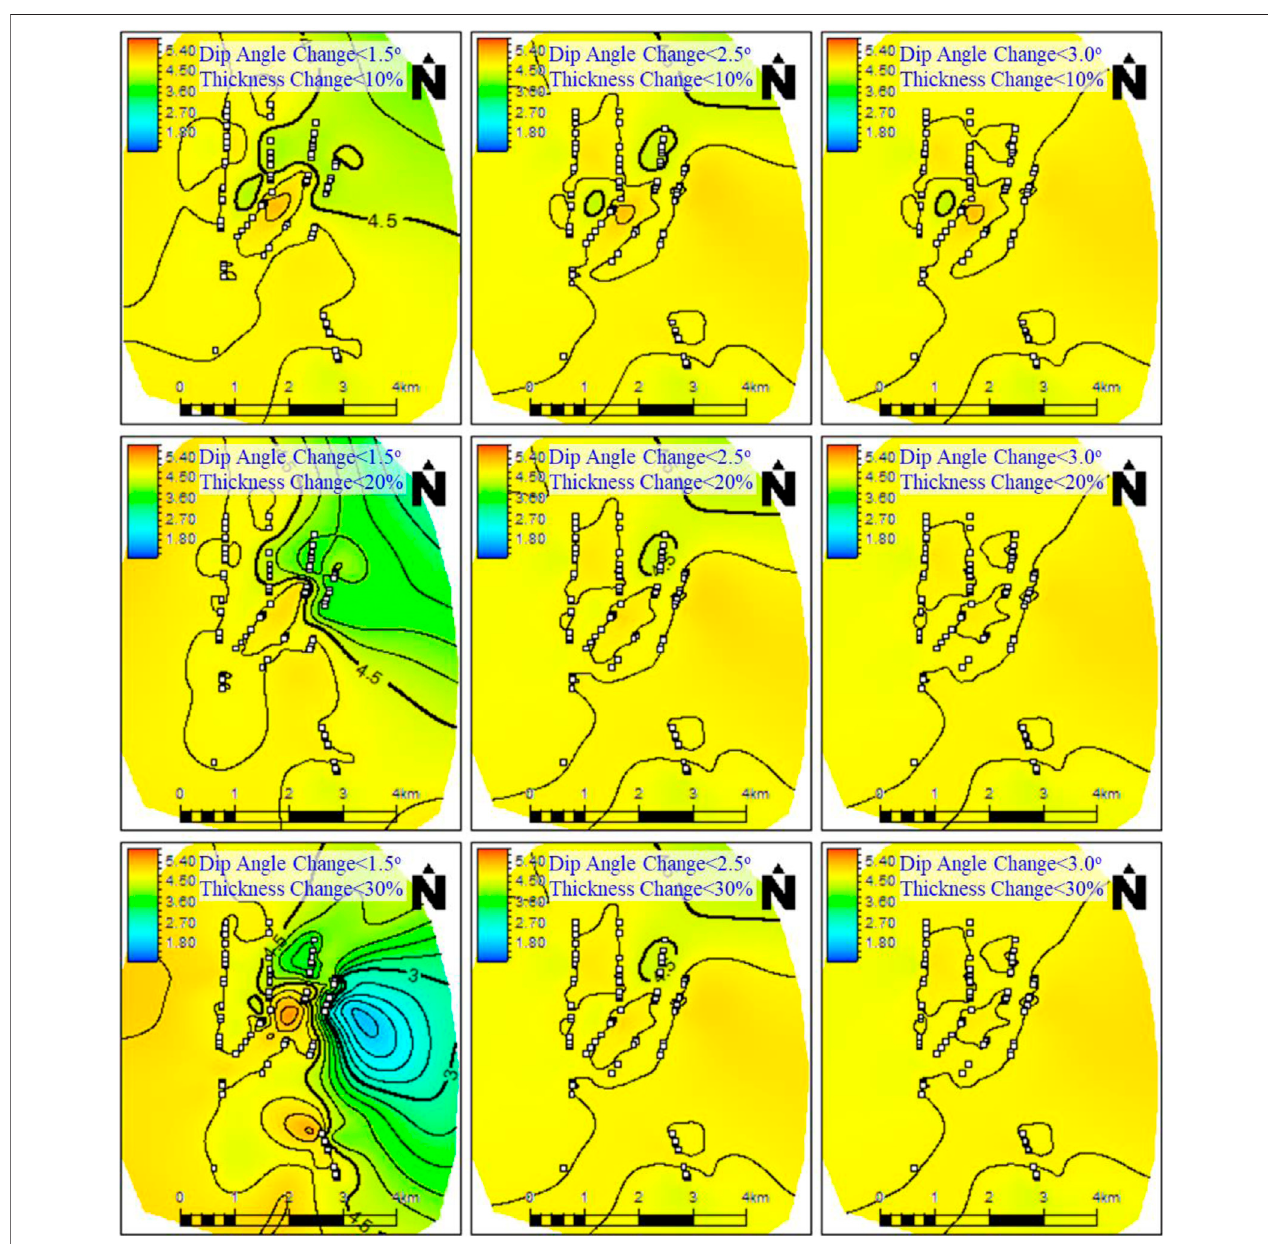
FIGURE9| IsopachmapsoftheWufengFormation intheJY-1districtafteradjustingitsTVTat thelocationofPVW-Asusingdifferentdipangle changethresholds and thickness change thresholds. The white- fi lled squares represent the location of formation tops in the vertical and horizontal wells.